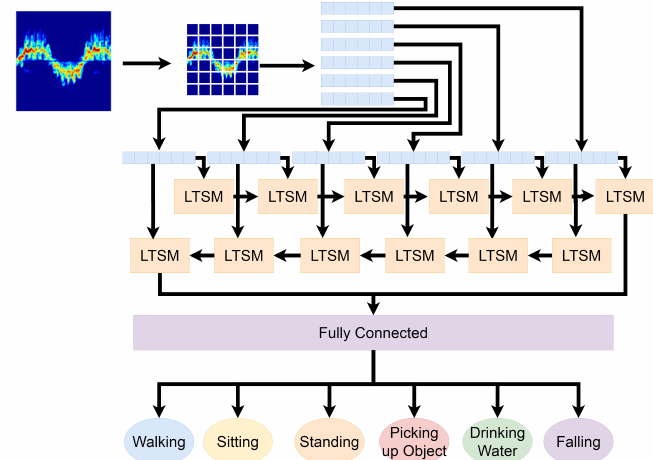
Figure 4. Visual representation of how BiLSTM works.